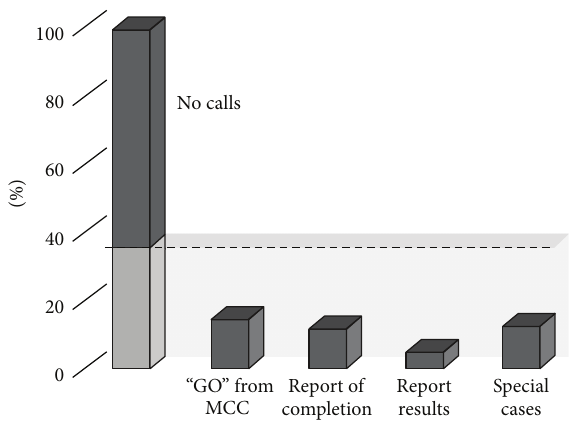
Figure 2: Types of communications used in procedures ( 𝑁 = 160